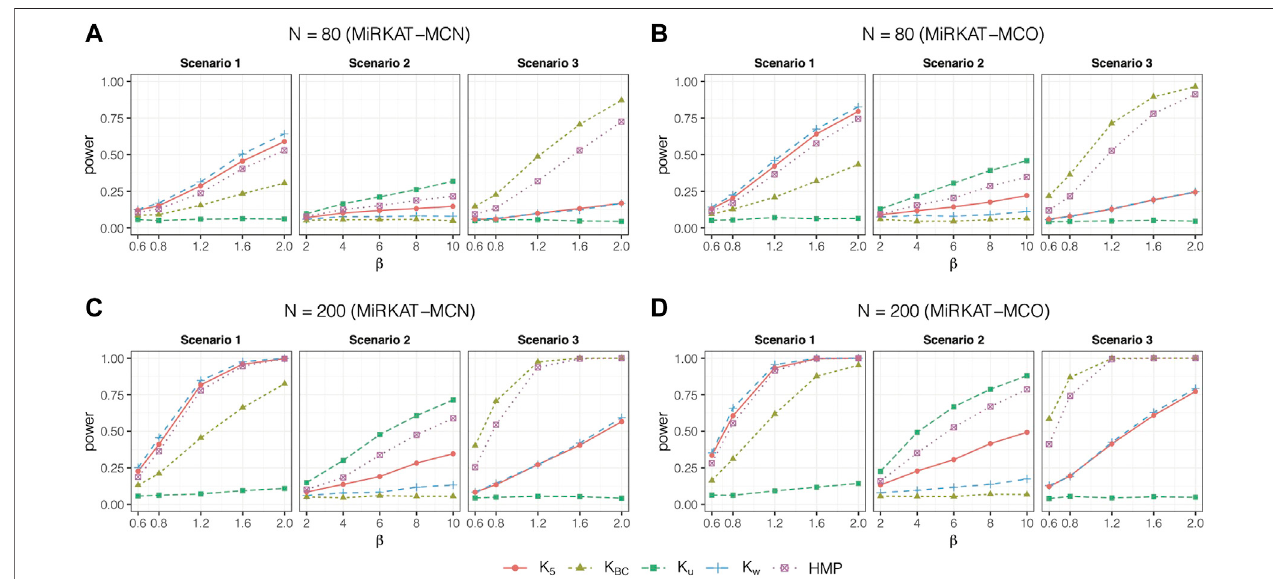
FIGURE1| StatisticalpowersofMiRKAT-MCforindependentdatawiththreecategories.Scenario1: A =Arandomlyselectedcommonclusteramong20clusters by PAM; Scenario 2: A = The rarest cluster among 20 clusters by PAM; Scenario 3: A = 10 most abundant OTUs. K w , the weighted UniFrac kernel; K u , the unweighted UniFrac kernel; K BC , the Bray-Curtis kernel; K 5 , the generalized UniFrac kernel with parameter 0.5; HMP, the omnibus test using harmonic mean p -value test. (A) MiRKAT-MCN with 80 total samples; (B) MiRKAT-MCO with 80 total samples; (C) MiRKAT-MCN with 200 total samples; (D) MiRKAT-MCO with 200 total